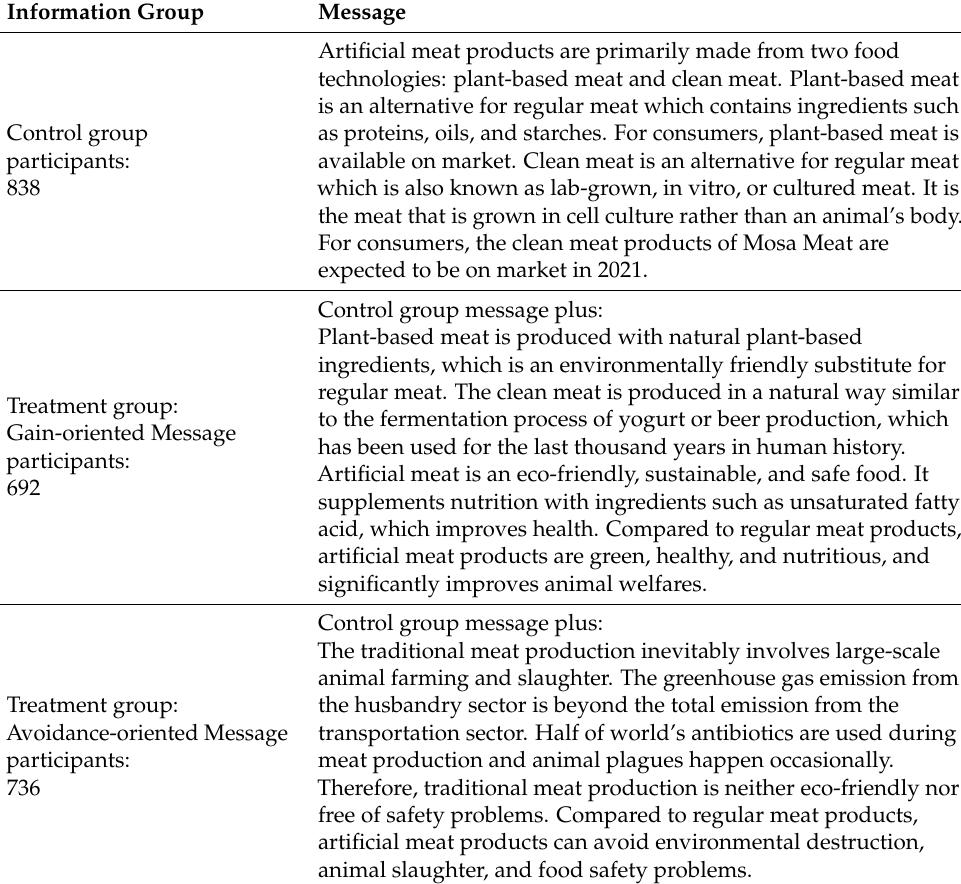
Table A1. Messages presented in control and treatment information groups.